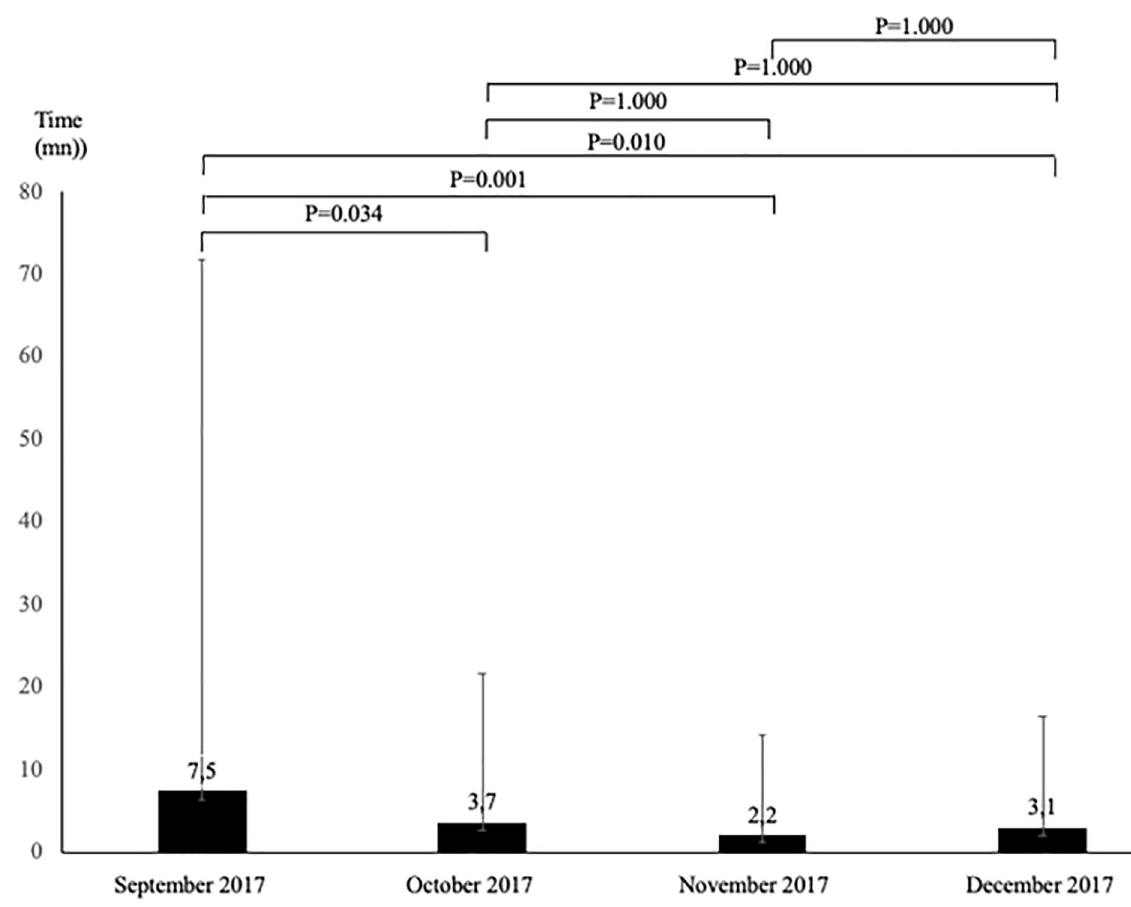
Fig 2. Evolution of time to fill ER 2 assessment from September to December 2017 (n = 1,800).